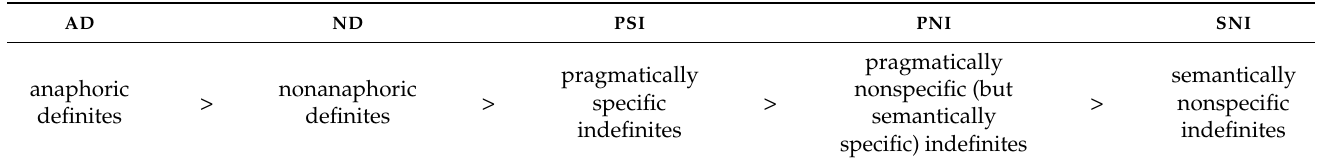
Table 2. The Reference Hierarchy (Dryer’s 2014), with